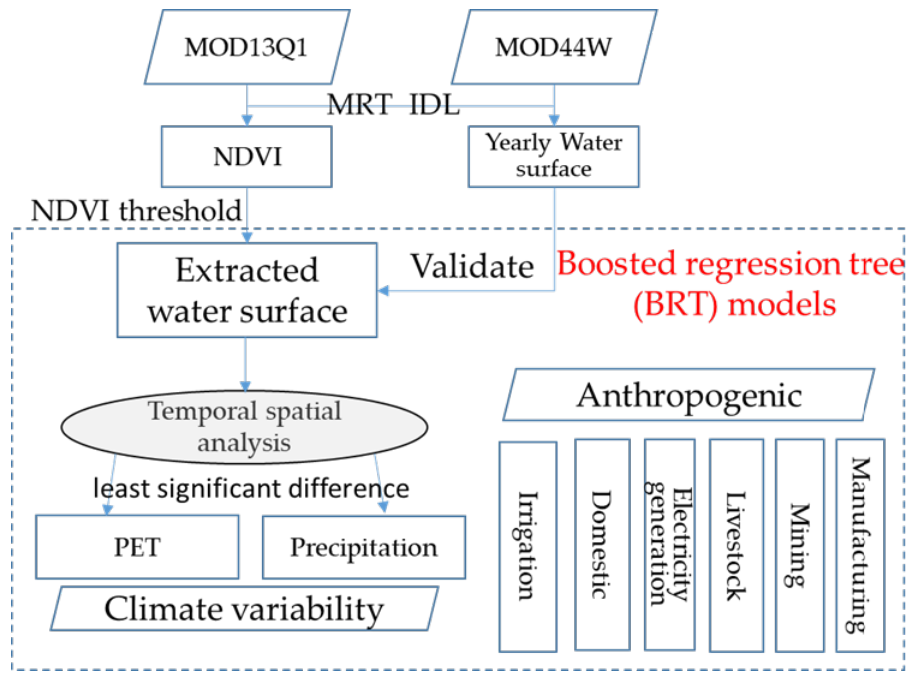
Figure 3. Schematic flow chart presenting the overall approach of the study. T MODIS Vegetation Indices 16-day L3 Global 250 m (MOD13Q1). MODIS 250 m land-water mask (MOD44W). Potential evapotranspiration (PET).